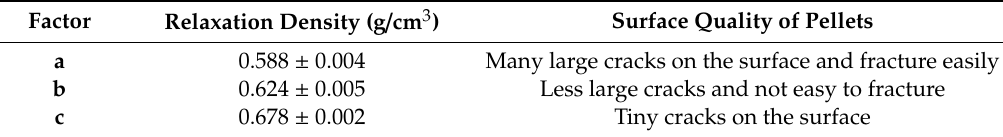
Table 2. Test results of relaxation density and surface quality of pellets.